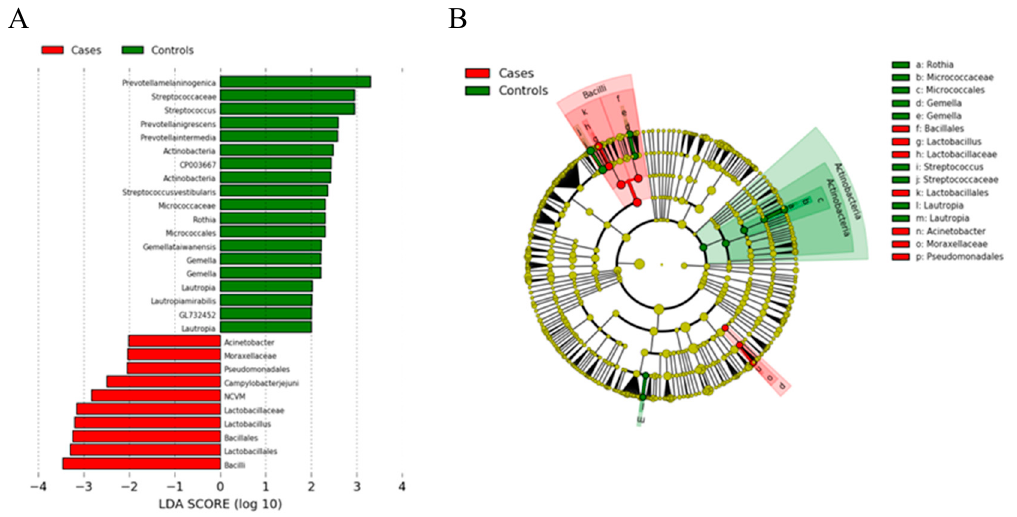
Figure 3. ( A ) Linear discriminant analysis of effect size (LEfSe) analysis plot of differentially abundant gastric microbial taxa between GC and control groups. ( B ) Cladogram representation of gastric microbiome taxa associated with GC based on the Ezbio database.